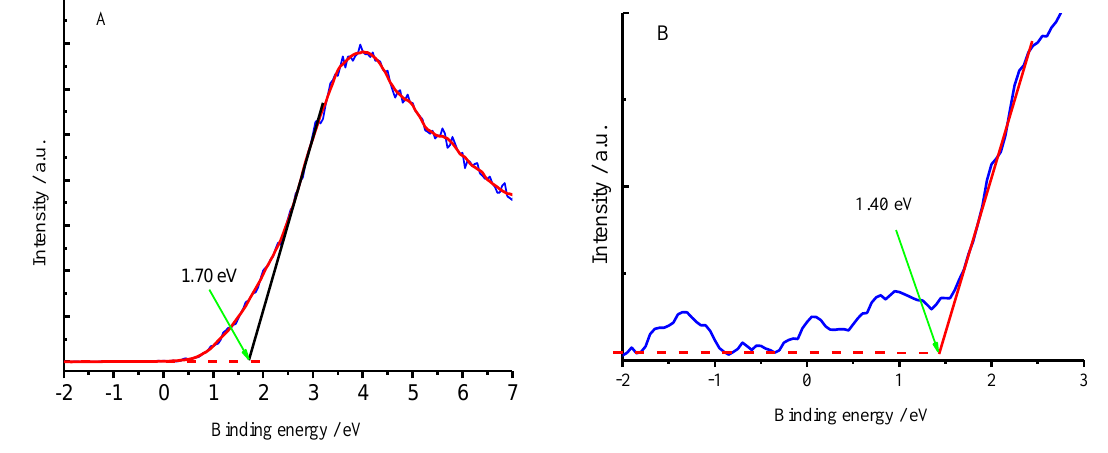
Figure 18. XPS valence band spectra of CuFe 2 O 4 /NG ( A ) and NG ( B ).